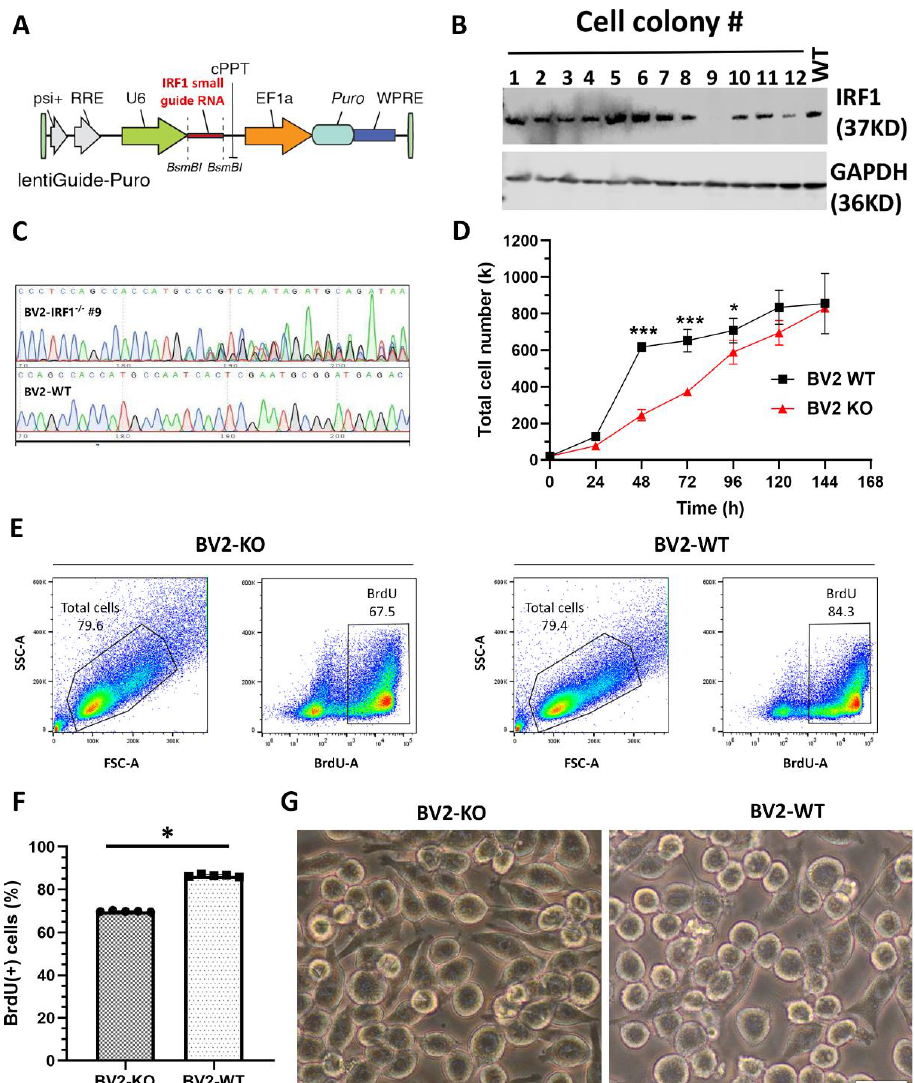
Figure 2. IRF1 knockout (KO) defers BV2 microglial proliferation. ( A – C ) IRF1 KO from BV2 microglial cells with CRISPR-Cas9 gene-editing technique. ( A ) The diagram depicting the insertion of IRF1 small guide (sg) RNA in the lentiviral plasmid. ( B ) The WB results showing that single-cell colony #9 is absent of IRF1 protein compared with the other cell colonies and wild-type (WT) cells. ( C ) DNA sequence showing the mutation of cell co lony #9′s gene loci compared to the BV2 -WT gene loci. ( D – F ) IRF1-KO defers the microglial cell proliferation rate. ( D ) Cell counts during BV2 cell growth. ( E ) Flow cytometry shows total live BV2 cells (left in the enclosed areas) and BrdU (+) BV2 cells (right in the boxed areas) for IRF1-KO BV2 (BV2-KO) and BV2-WT counterparts. ( F ) BrdU (+) cell numbers (%). n = 6. * p < 0.05; *** p < 0.001. ( G ) Cell morphological differences of BV2-KO and BV2-WT cells. Scale bar: 20 µm